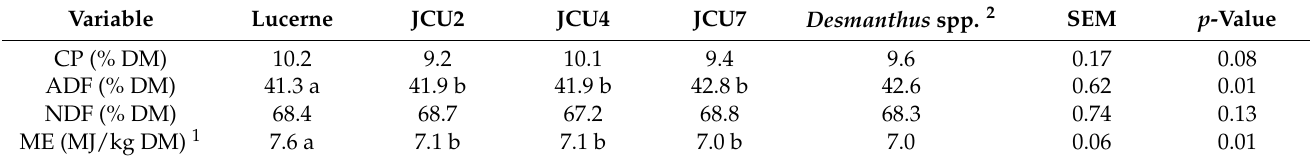
Table 3. Nutritive value (mean ± s.e.) of diets containing lucerne and Desmanthus spp. cultivars determined by NIRS.